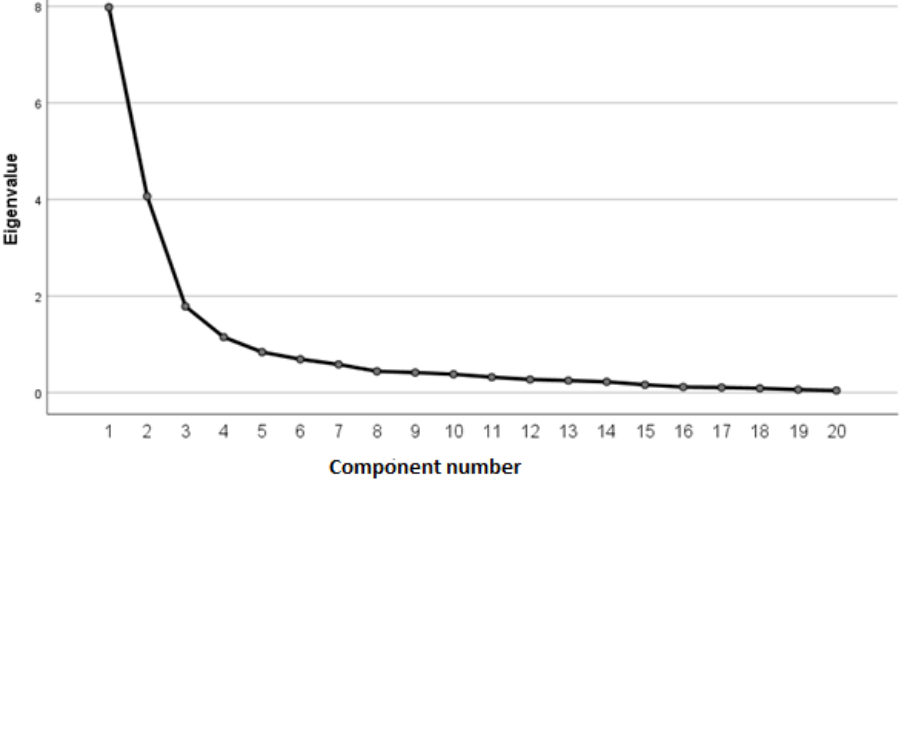
Figure 1. Scree plot for exploratory factor analysis of the supportive accountability